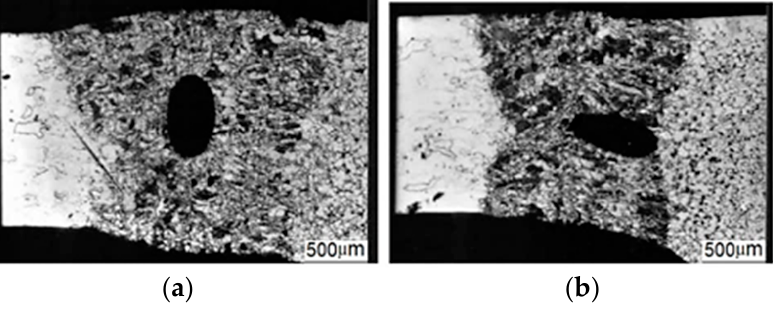
Figure 2. Micrographs of the TWB1 laser-welded specimens: ( a ) the pore in central area of FZ, ( b ) the pore near HAZ.